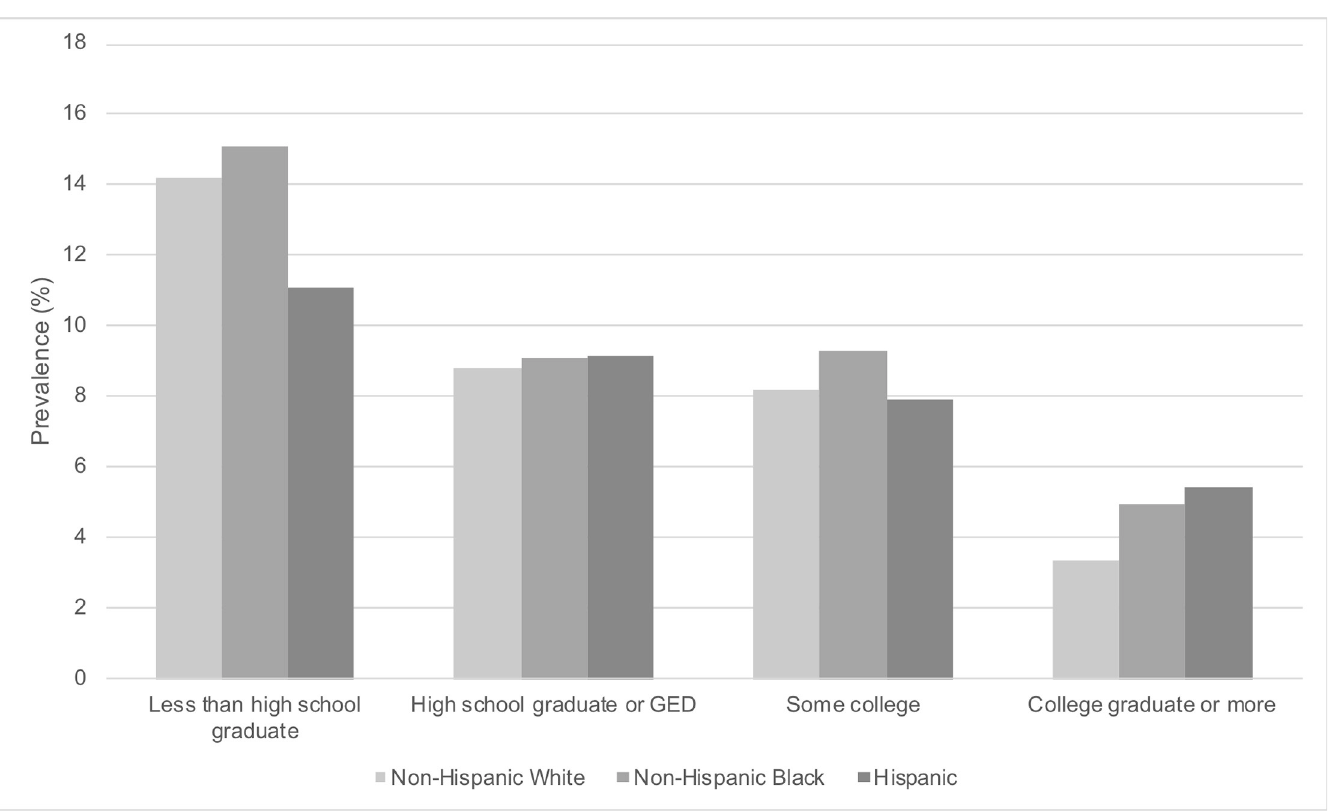
Fig 2. Weighted prevalence of probable depression by race/ethnicity and educational attainment in U.S. adults (N = 26,382). The National Health and Nutrition Examination Survey (NHANES) 2007–2016. Missing values for education (n = 19). Weighted to the U.S. population. GED is the general education diploma. Probable depression defined by Patient Health Questionnaire-9 (PHQ-9) cutoff of �